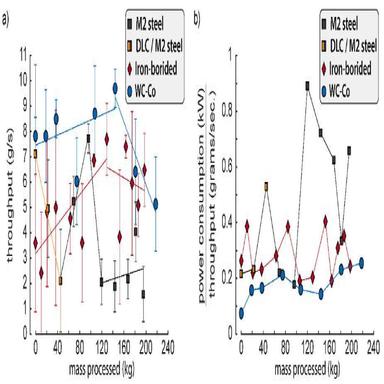
Knife milling performance using different blade materials. a) Feedstock throughput during the test; b) Power consumption normalized by throughput during the test.